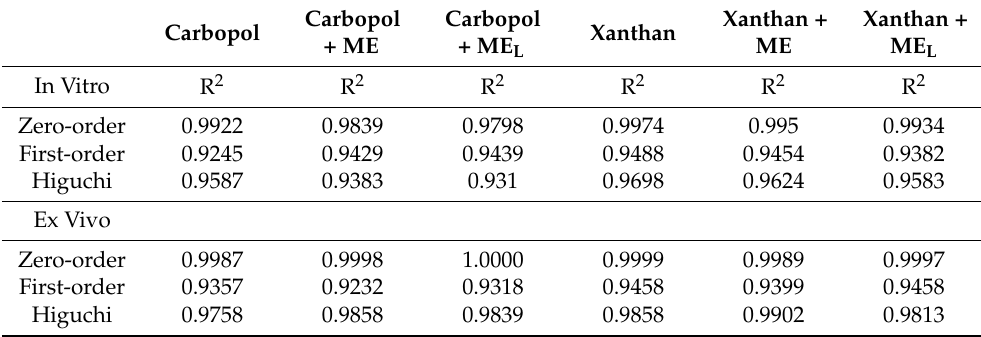
Table 5. The coefficients of determination (R 2 ) for zero-order kinetics, first-order kinetics, and the Higuchi